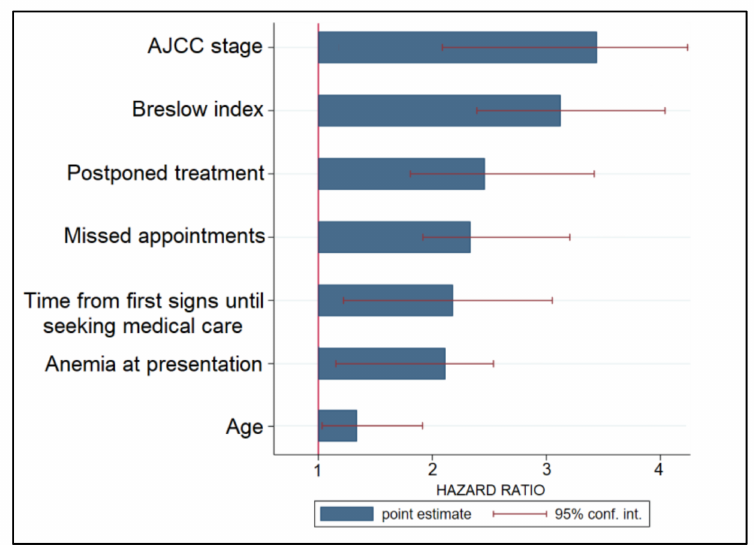
Figure 4. Risk factor analysis for disease progression in patients with malignant